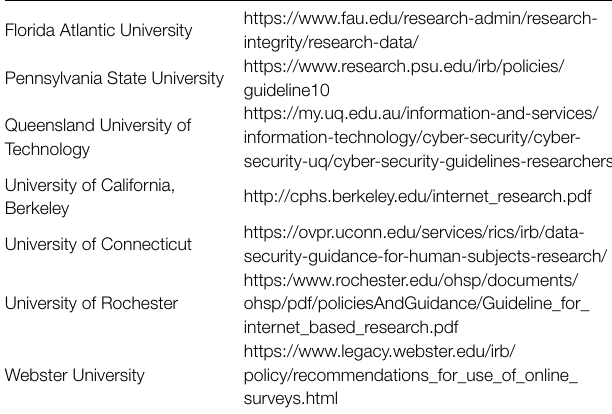
TABLE 1 | Organizations with published guidelines for internet-based research involving minors.